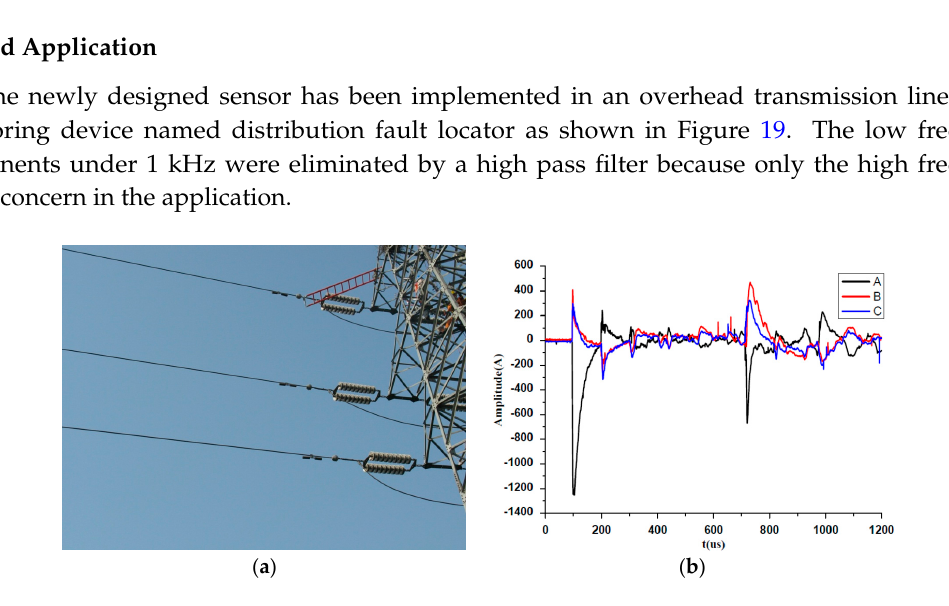
Figure 19. The field application of the proposed sensor. ( a ) Locators installed in field; ( b ) The captured fault current waveforms.